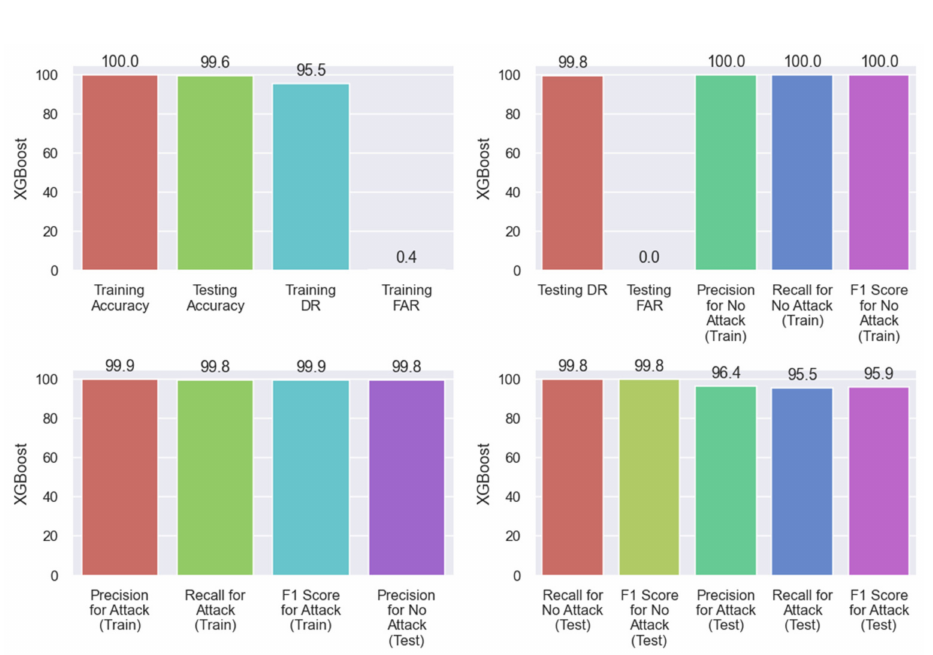
Figure 7. XGBoost